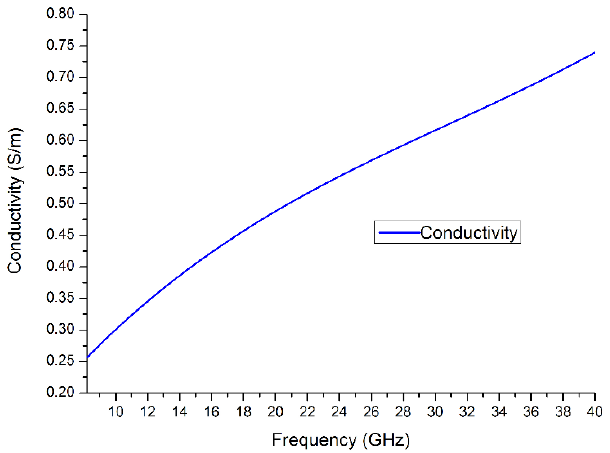
Figure 10. Conductivity spectra of solid polymer electrolyte from 8.2 GHz to 40 GHz.